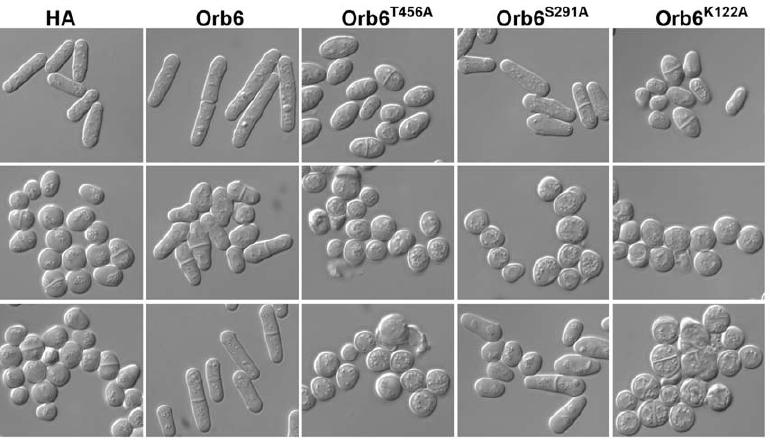
Figure 5. Conserved phosphorylation sites are essential for Orb6 function. HA-Orb6, HA-Orb6 T456A , HA-Orb6 S291A or HA-Orb6 K122A were expressed in WT (SP199), nak1 and orb6 ts cells using plasmids derived from pREP3X containing the thiamine repressible nmt1 promoter. Cells were grown in thiamine free liquid PMAU media to an O.D. =1.0 at 33 u C and examined by DIC microscopy.